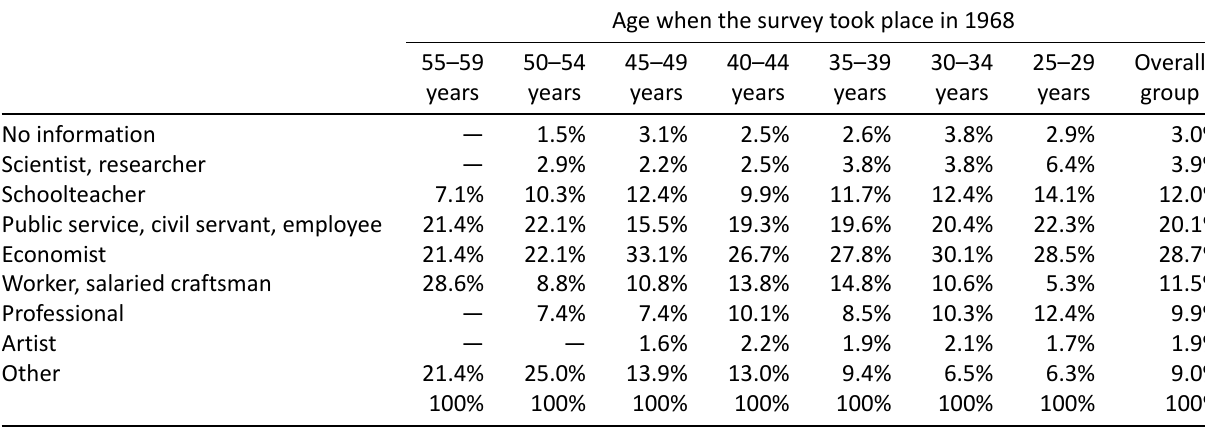
Table 1. Occupation groups of the fathers of former Studienstiftung scholars between 1948 and